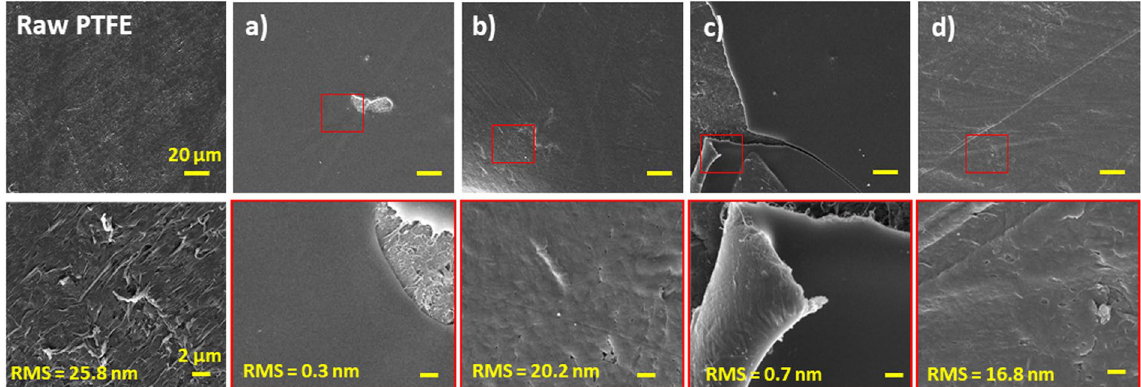
Figure 7. SEM images with inserted yellow values of roughness measured by AFM. Morphology and roughness of raw PTFE is compared to ( a ) PMEOx layer deposited after PTFE pre-treatment, ( b ) PMEOx layer deposited on pre-treated PTFE after washing, ( c ) air-plasma treated PMEOx layer, ( d ) air-plasma treated PMEOx layer after washing.